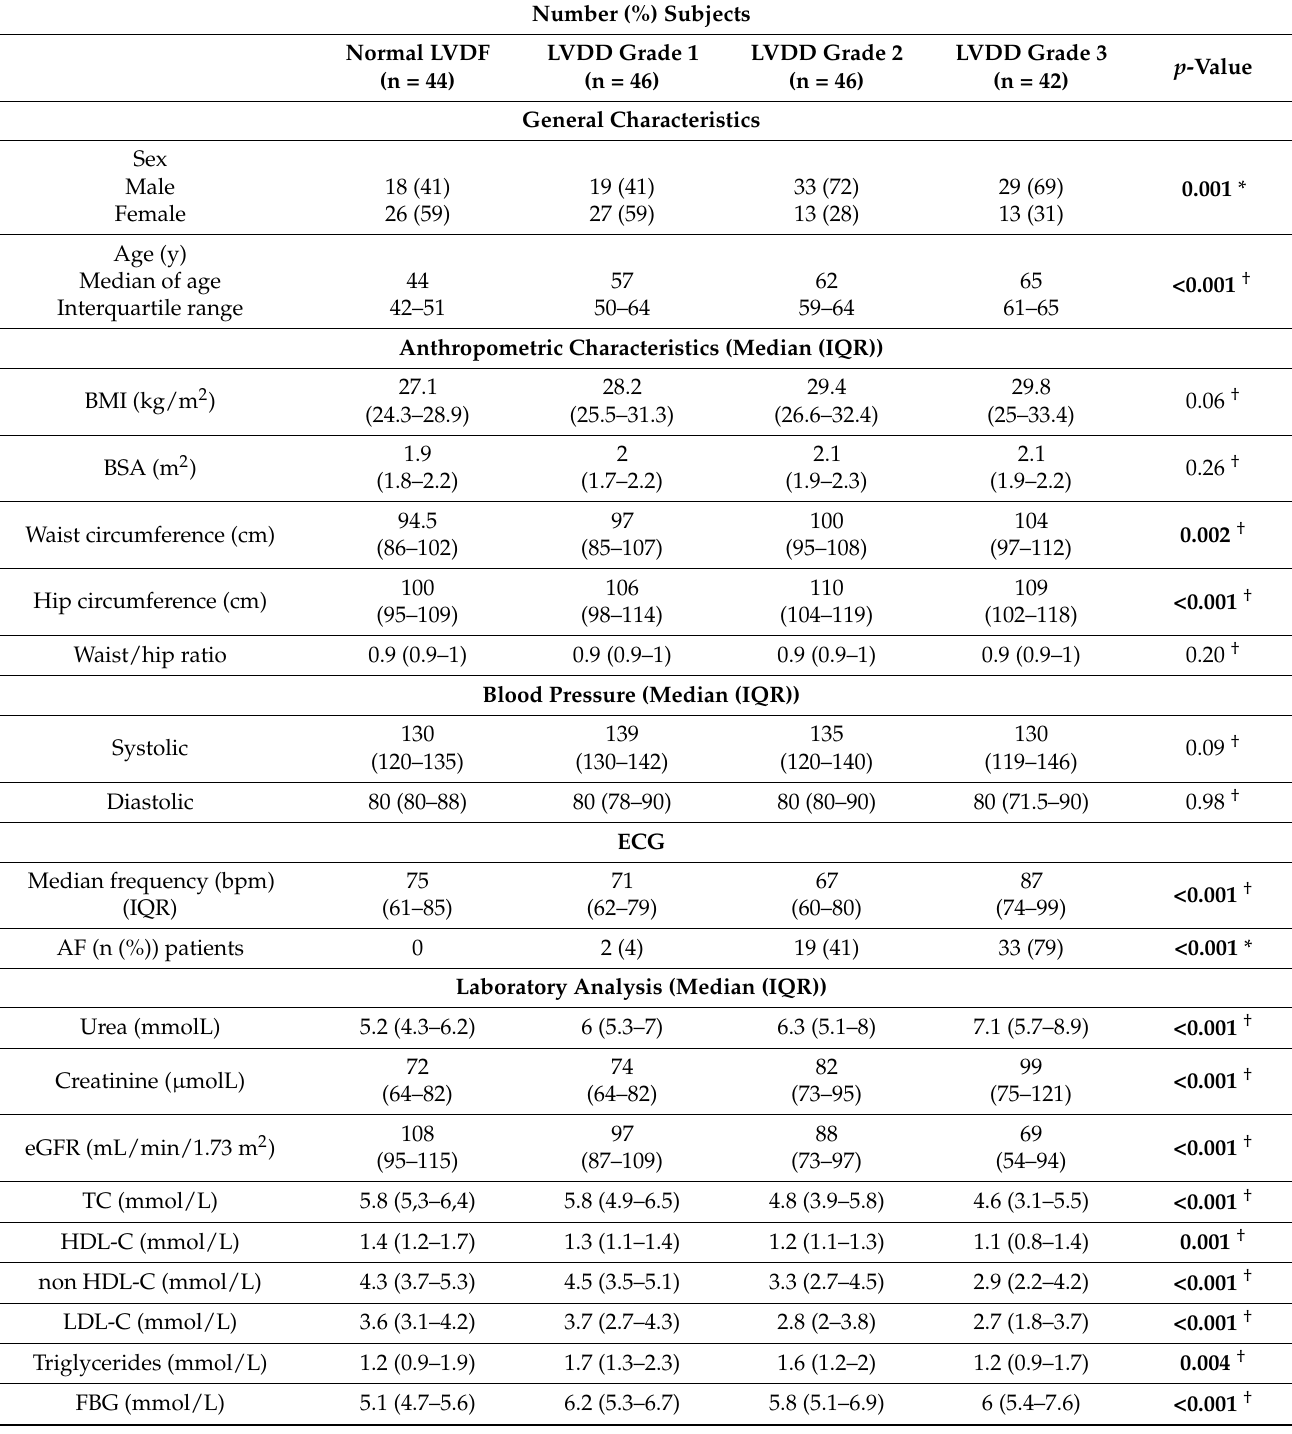
Table 1. General, clinical, and laboratory characteristics and prevalence of CV risk factors of the subjects in the study